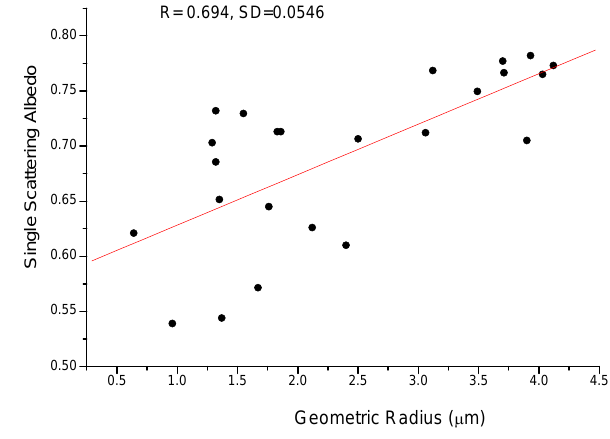
Fig. 10. Scatter plot showing the variation of SSA (at 550nm) with geometric mean radius (in mm) evaluated from surface aerosol size dsitribution for a typical winter day (19 February